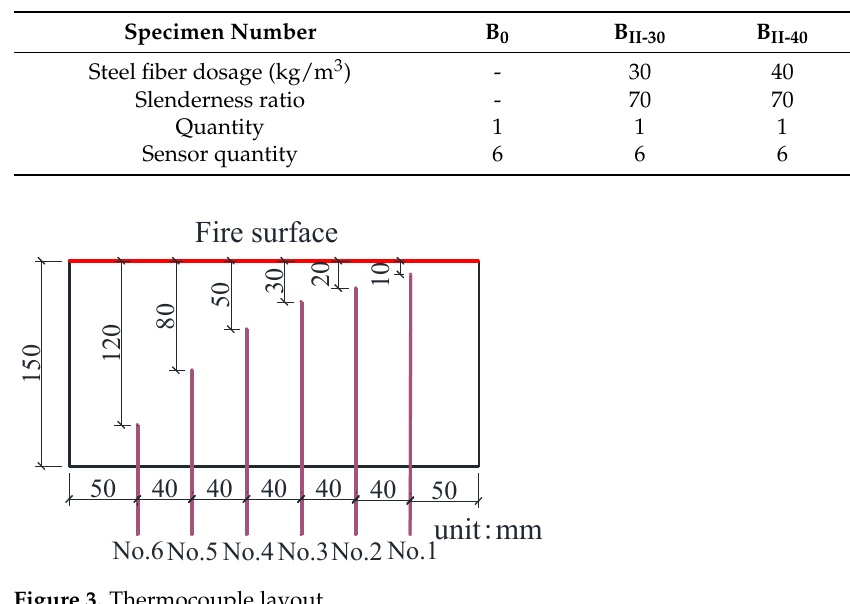
Figure 3. Thermocouple layout.